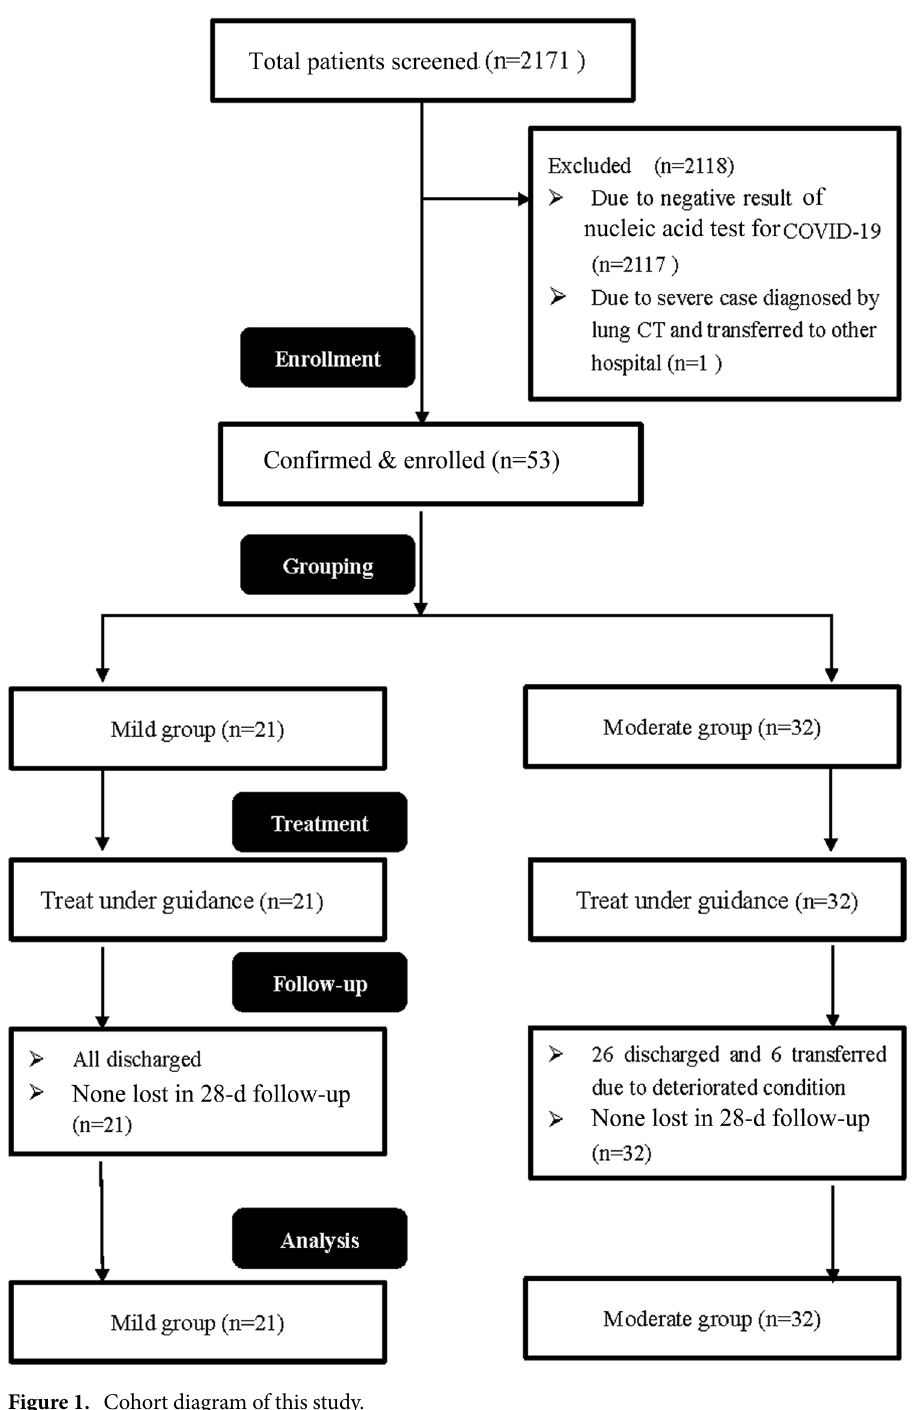
Figure 1. Cohort diagram of this